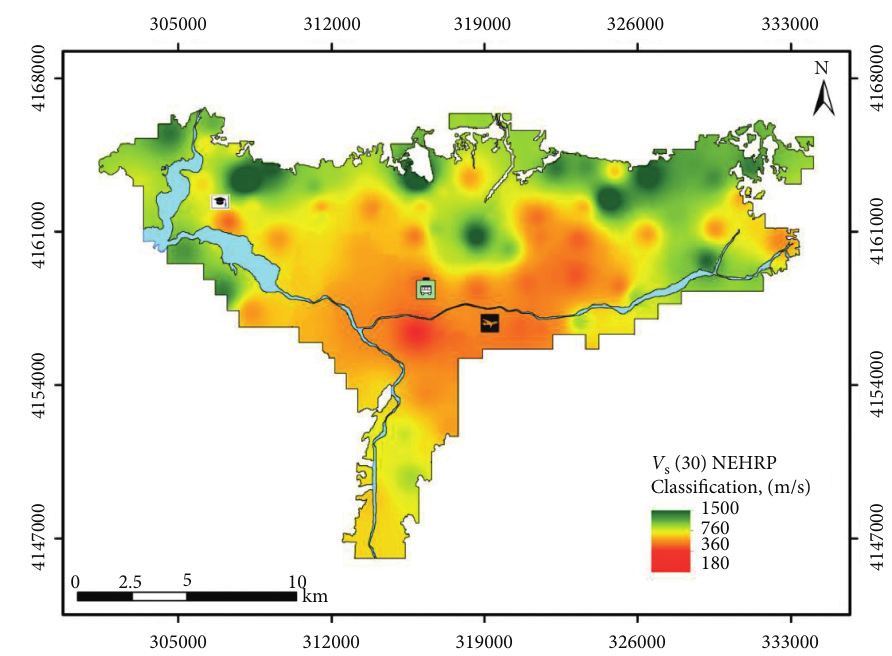
Figure 6: V S 30 map of Kahramanmaras area.